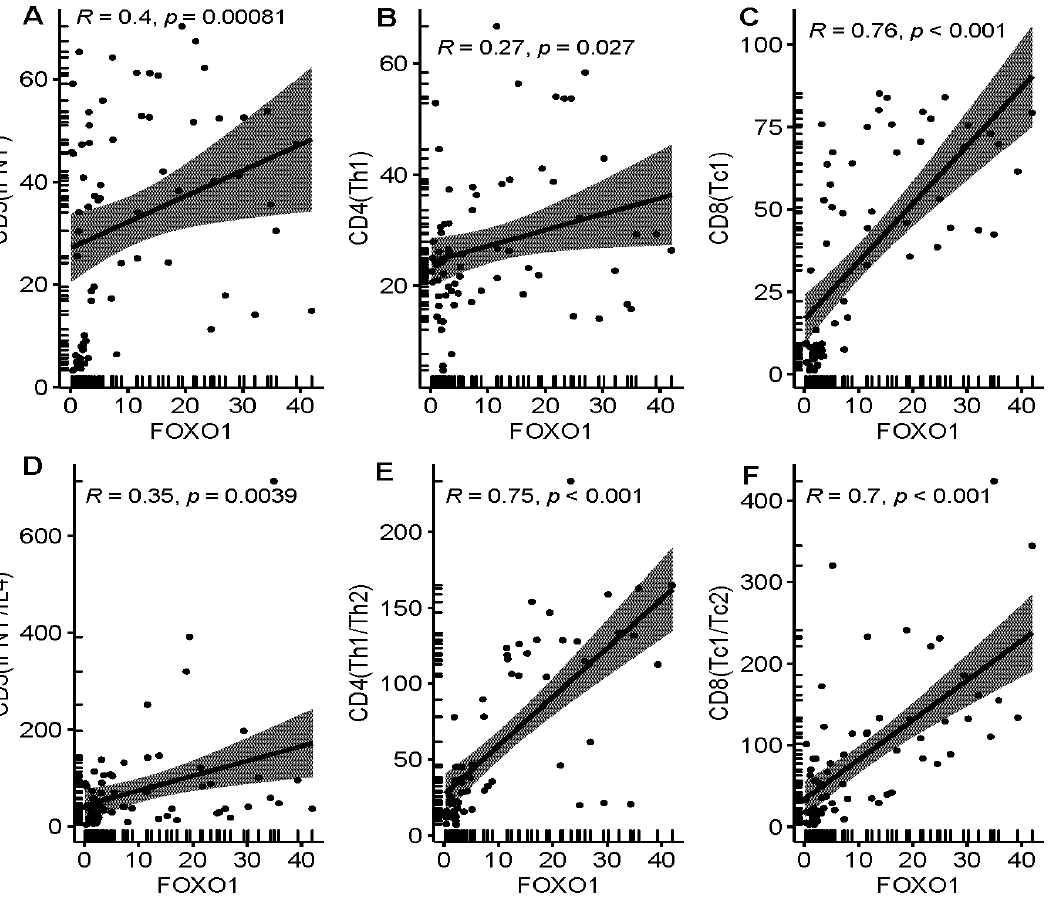
Figure 2. Association of FOXO1 expression with cellular immunity and polarization in MDS. ( A ) showed FOXO1 correlated weakly with CD3T (IFN Ƴ ), ( B ) showed FOXO1 expression weakly correlated with CD4T (Th1), ( C ) manifested FOXO1 expression significantly correlated with CD8T (Tc1), ( D ) manifestd FOXO1 expression weakly correlated with CD3T polarization, ( E ) demonstrated FOXO1 expression significantly correlated with CD4T (Th1/Th2), and ( F ) demonstrated FOXO1 expression also significantly correlated with CD8T polarization.